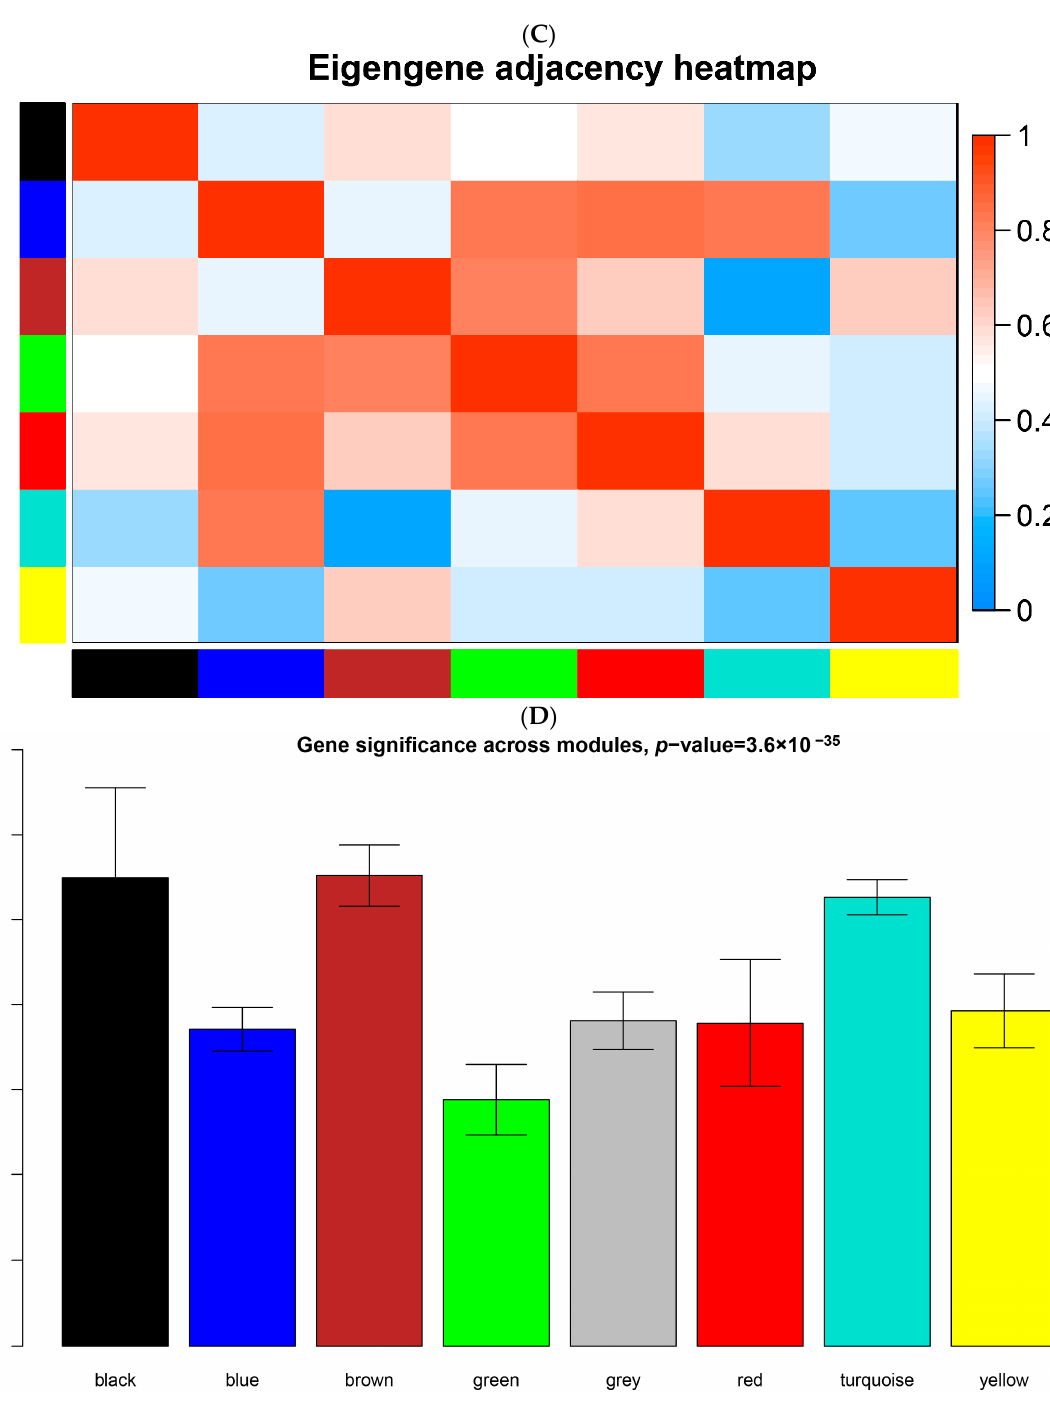
Figure 2. Weight gene co-expression network analysis. ( A ) Scale independence and mean connectivity analysis. ( B ) Cluster dendrogram and module partitioning of the co-expression gene modules. The 8 colors indicate the corresponding gene co-expression modules. ( C ) Heatmap for module eigengenes. The correlation of module eigengenes increases gradually with color changing from blue to red. ( D ) Significant modules associated with peripheral immunity in PD patients before and after Tai Chi intervention.